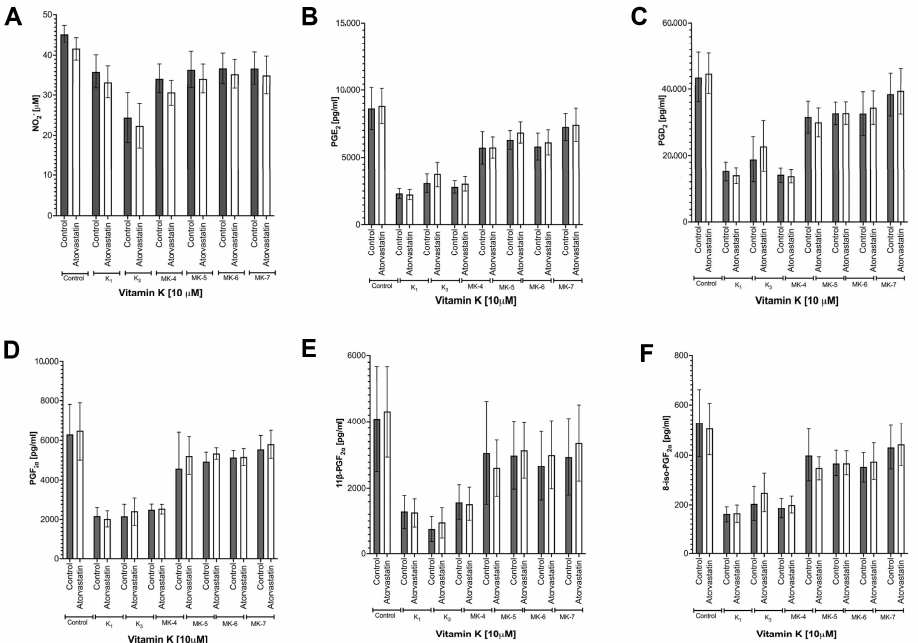
Figure 5. The lack of involvement of endogenous MK-4 in anti-inflammatory activity of exogenous vitamins K in RAW Figuer 5 264.7 cells stimulated with LPS. To determine the influence of vitamins K interconversion on anti-inflammatory activity of various forms of vitamins K, the production of endogenous MK-4 was blocked using 1 µ M atorvastatin. Then, NO 2 − ( A ) and eicosanoid ( B – F ) production were measured. Data are shown as means ± SD of three independent experiments with technical replicates excluding outliers ( n = 6–9). Statistical significance was evaluated by two-way ANOVA followed by Sidak’s post hoc multiple comparisons using GraphPad Prism 9